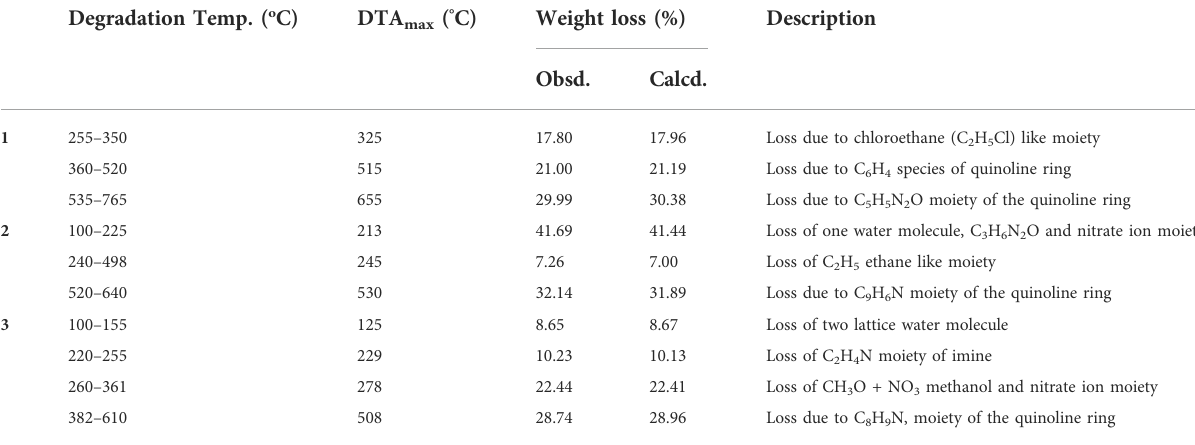
TABLE 4 TGA and DTA data of Zn(II), Cu(II) and Ni(II) complexes. Degradation Temp. ( o